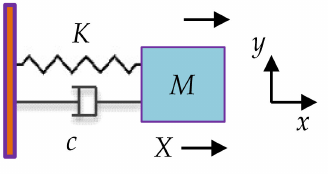
Figure 6. Mass-spring-damper model of a single